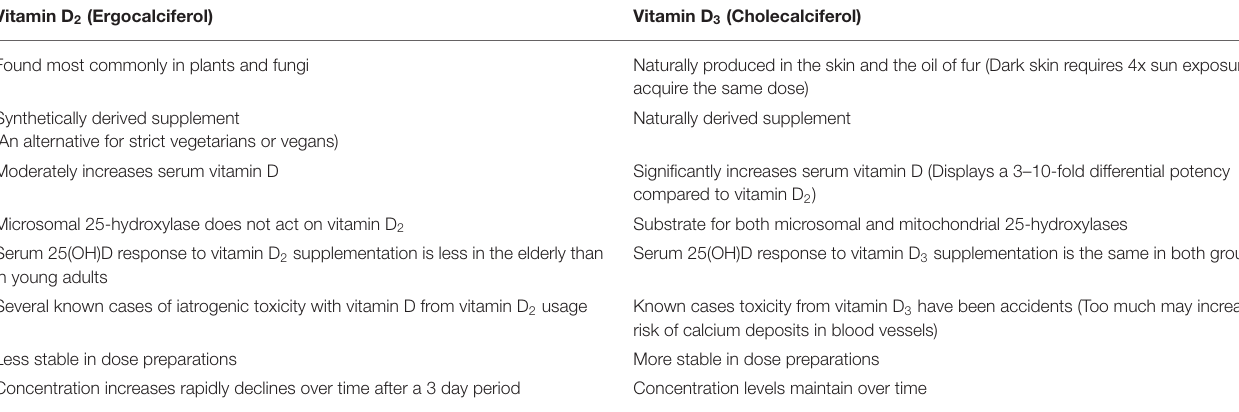
TABLE 1 | Summary of ergocalciferol supplementation compared to cholecalciferol supplementation. Vitamin D 2 (Ergocalciferol) Vitamin D 3